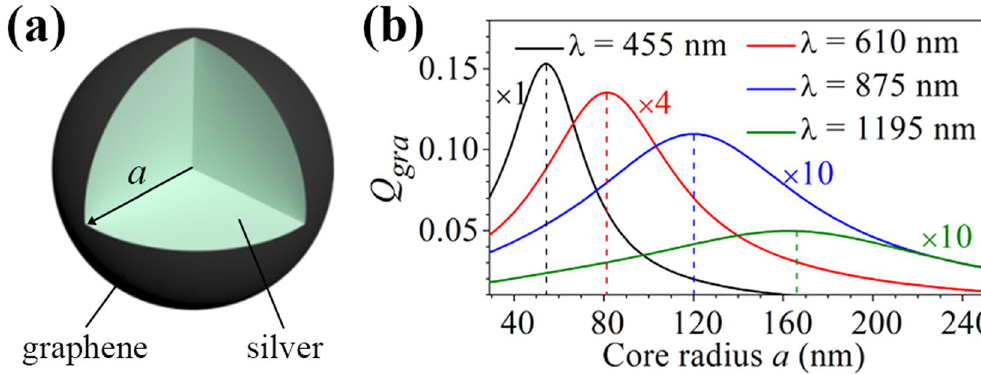
Figure 1. ( a ) Schematic of a graphene-wrapped solid silver nanosphere. ( b ) Graphene absorption efficiencies as a function of the radius of the silver nanosphere calculated at four different wavelengths of λ = 455 nm (black), λ = 610 nm (red), λ = 875 nm (blue) and λ = 1195 nm (green). For clarity, the graphene absorption efficiencies at the wavelengths of λ = 610 nm, λ = 875 nm and λ = 1195 nm are amplified 4, 10 and 10 times, respectively. For each wavelength, a dashed vertical line indicates a particular silver core radius with which the graphene absorption efficiency can achieve the maximum